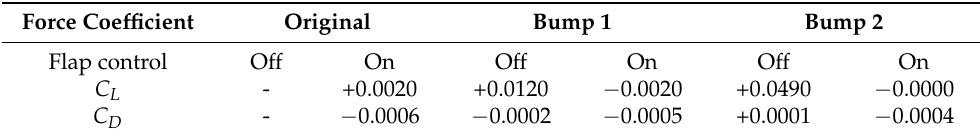
Table 5. Changes of aerodynamic coefficients for different configurations with and without the closed-loop flap control.